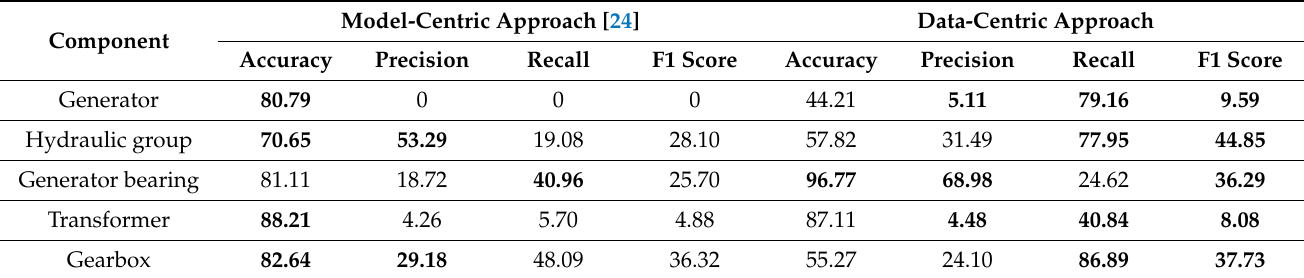
Table 6. The values of F1 score were higher for all considered components while the values of precision and recall were mostly better. Accuracy was mostly lower for the data-centric approach, but as it was discussed in Section 3.1, this metric is misleading for skewed data sets. Table 6. Comparison of the results from model-centric and data-centric approach. Values are presented in percents.